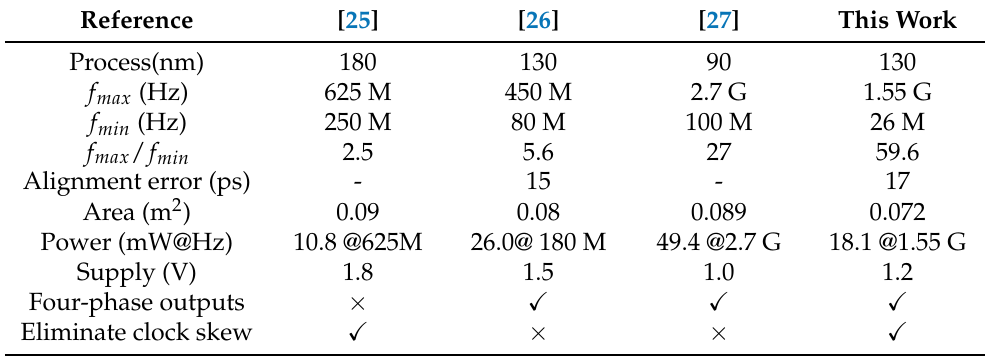
Table 1. Performance comparison of